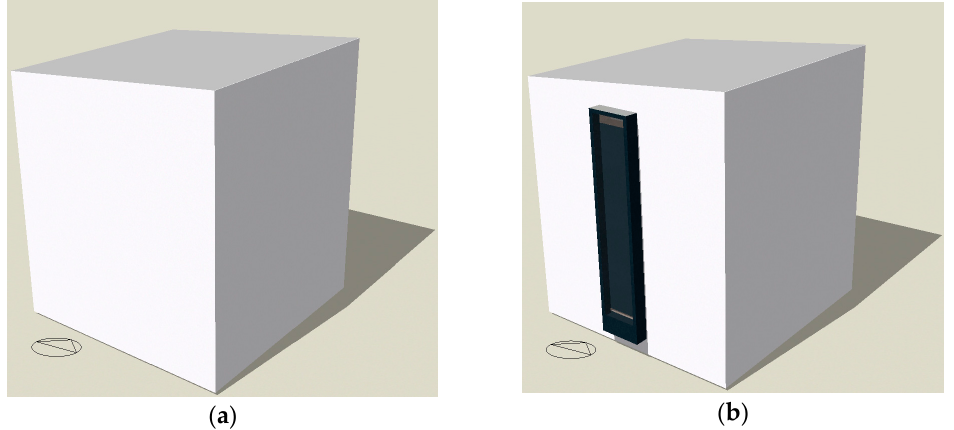
Figure 6. DesignBuilder models southeast views: ( a ) Module 1 (Reference); ( b ) Module 2 (Trombe wall, TW).